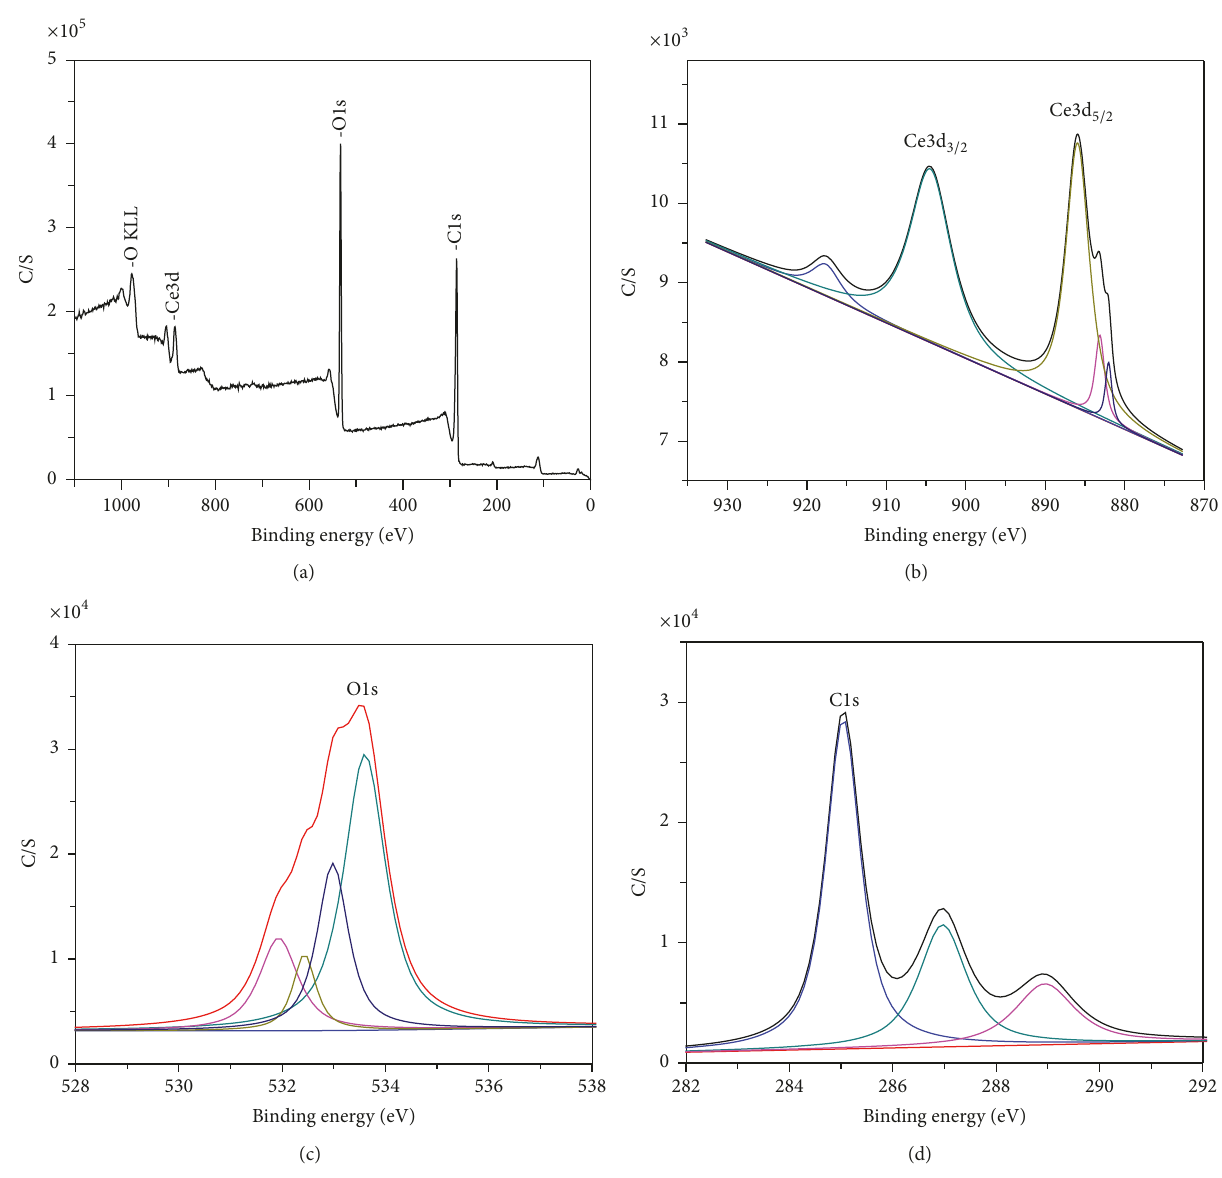
Figure 3: (a) XPS survey spectrum of Ce-bpdc, (b) high-resolution Ce 3d core-level XP spectrum, (c) high-resolution O1s core-level XP spectrum, and (d) high-resolution C1s core-level XP